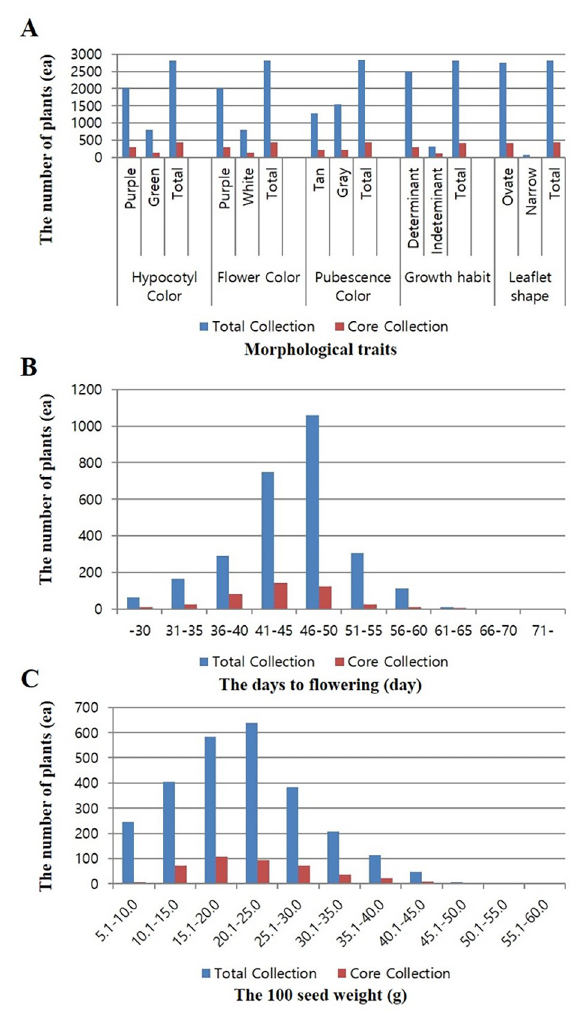
Fig 7. Morphological trait measurements for the core collection and the total collection. (A) Flower color, hypocotyl color, pubescent color, growth habit, and leaflet shape in the core collection and total collection. (B) Days to flowering in the core collection and total collection. (C) The 100-seed weight in the core collection and the total